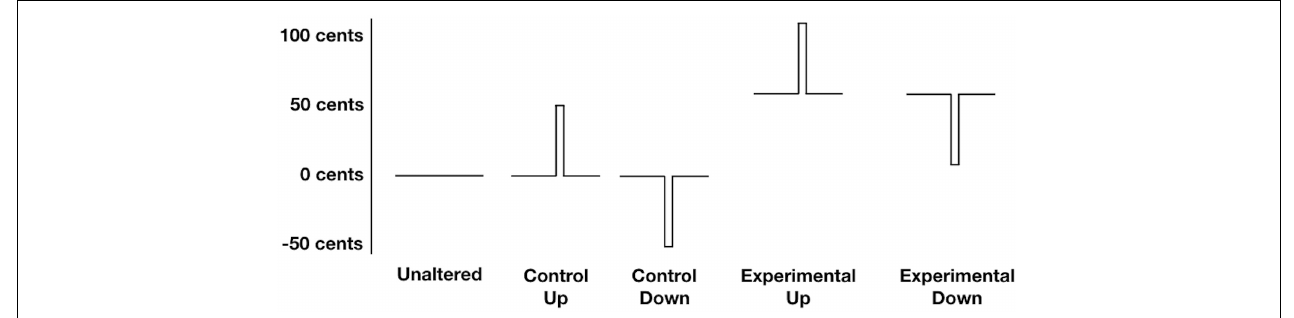
FIGURE 1 | Schematic Representation of the five experimental conditions. During the unaltered condition participants listened to their unaltered auditory feedback. During the control up and control down conditions, the fundamental frequency of participants’ auditory feedback was unaltered at vocalization onset, but was then briefly perturbed upwards 50 cents, or downwards 50 cents, respectively. During the experimental up and experimental down conditions, the fundamental frequency of participants’ auditory feedback was raised by 50 cents at vocalization onset, and was then briefly perturbed upwards 50 cents (for a total deviation from baseline of 100 cents), or perturbed downwards 50 cents (returning participants fundamental frequency to baseline), respectively.